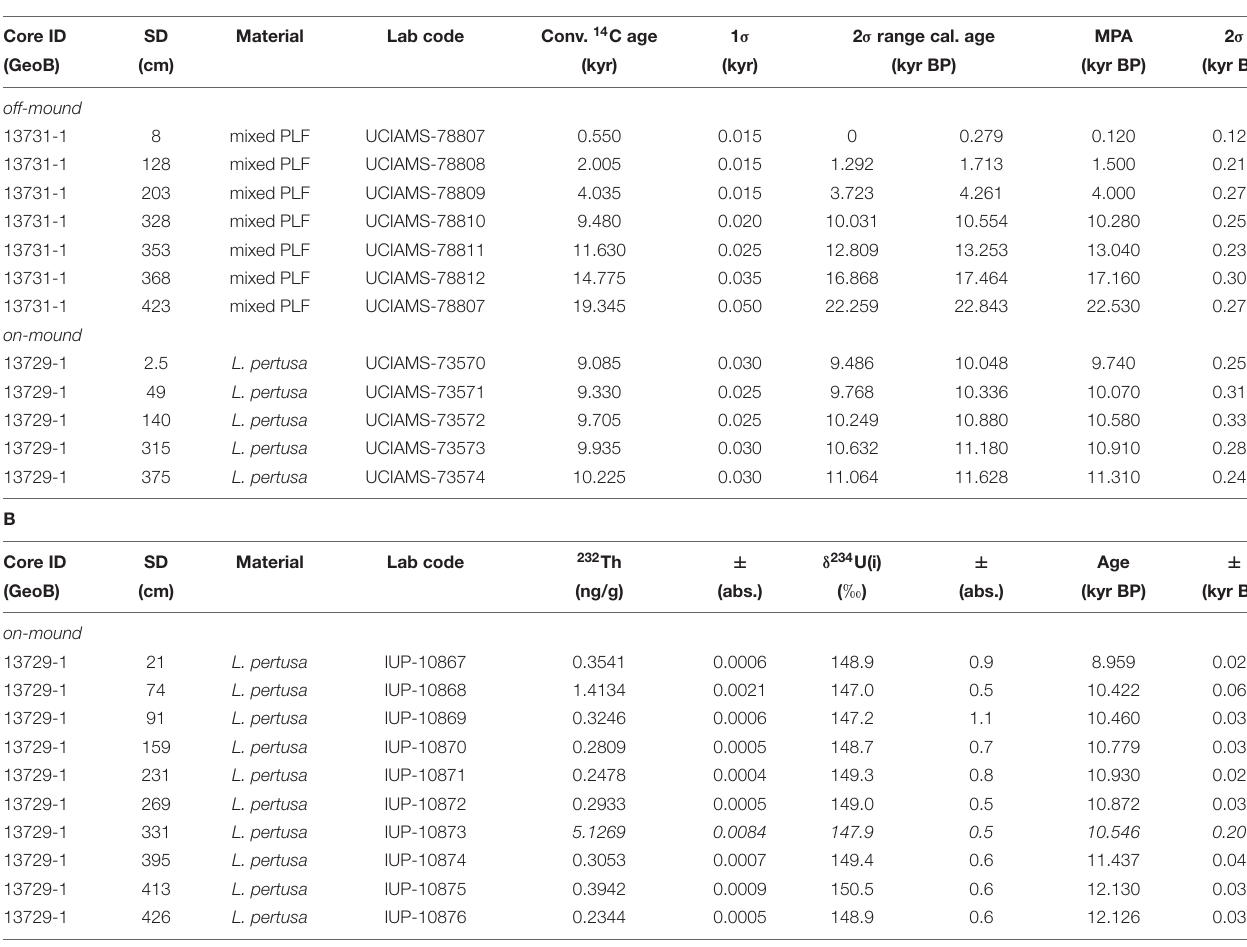
TABLE 2 | (A) AMS 14 C dates obtained from mixed planktonic foraminifera (PLF) of the off-mound core GeoB13731-1 and from cold-water coral fragments ( Lophelia pertusa a.k.a. Desmophyllum pertusum ) of the on-mound core GeoB13729-1. The AMS 14 C ages were corrected for 13 C and converted into calendar ages using with CALIB 8.20 (Stuiver et al., 2021; http://calib.org/calib/calib.html). For the calibration of the conventional AMS 14 C, the MARINE 20 calibration curve has been applied (Heaton et al., 2021) with a local reservoir age correction of (cid:49) R = − 90 ± 80 years accounting for a deglacial to Holocene marine reservoir age of R = 370 ± 40 years (according to Siani et al., 2000; Reimer and McCormac, 2002; Siani et al., 2011). SD: sampling depth, MPA: median probability age. (B) U/Th dates obtained from cold-water coral fragments ( L. pertusa ) of the on-mound core GeoB13729-1. Provided are 232Th concentrations and decay corrected 234 U/ 238 U activity ratios [ δ 234 U(i)] calculated from the given ages and with λ 234 U: 2.82206 ( ± 0.00302) × 10 − 6 yr − 1 ). The age at 331 cm core depth is marked in italics as it is most likely affected by diagenetic alternation as indicated by the high 232 Th